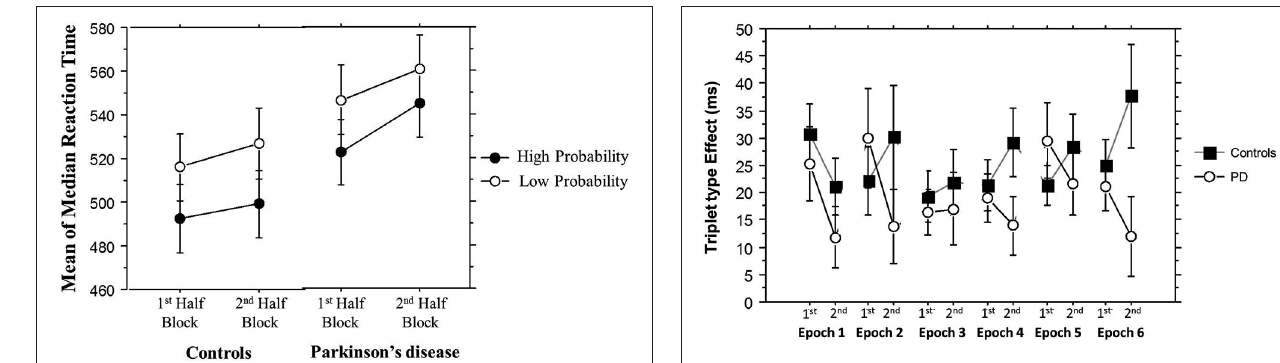
FIGURE 5 | Overall mean of median reaction time (ms) by Half Block and Group . Bars indicate standard error.